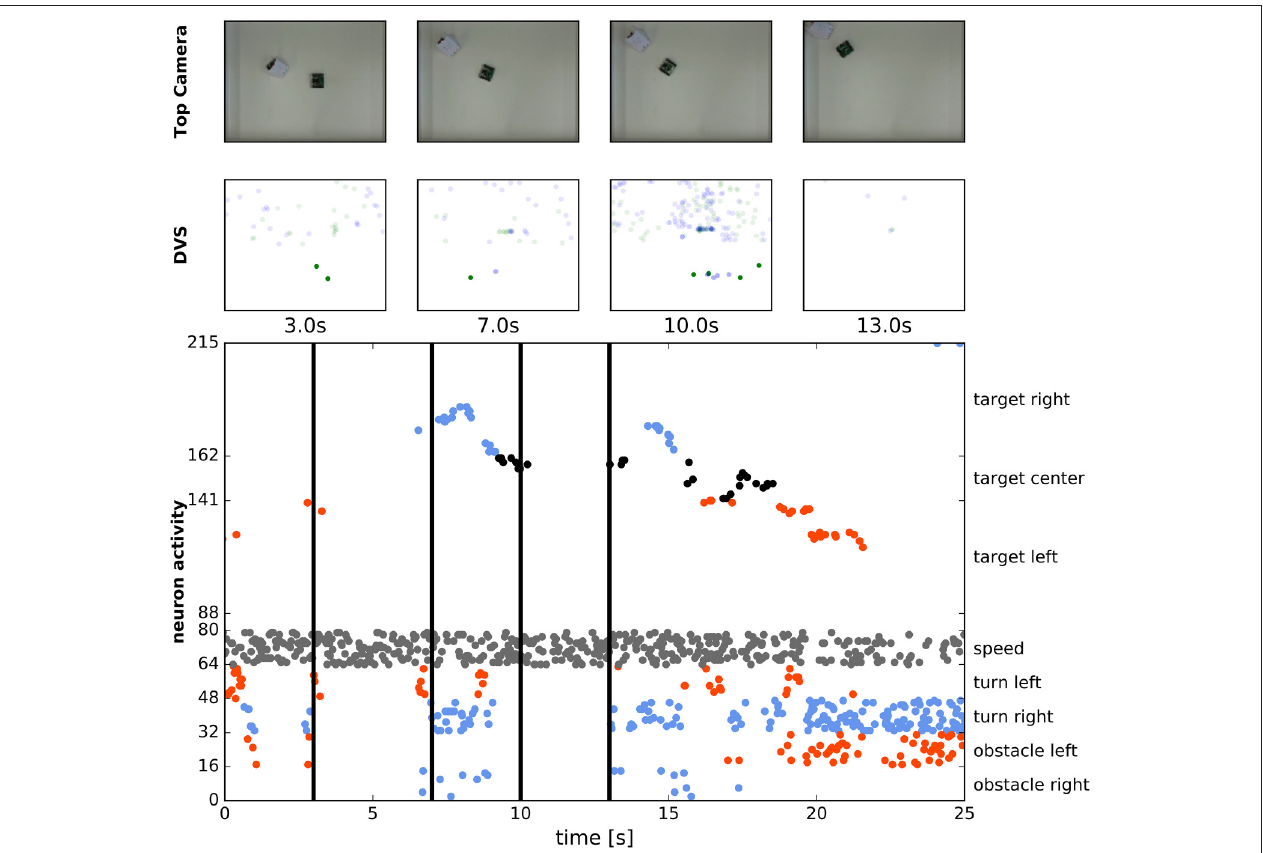
FIGURE 15 | Chasing a moving target. First row: Snapshots from the overhead camera showing the robot controlled by the ROLLS chip chasing a manually controlled robot. Second row: Summed eDVS events from 500 ms time windows around the same moments. Events from the upper part were used for target acquisition, events from the lower part—for obstacle avoidance. Bottom row: Spiking activity of all neurons on the ROLLS chip over the time of the experiment. Vertical line show the moments in time, selected for the first two rows. Red dots are spikes from the “left” populations and blue dots are spikes from the “right”